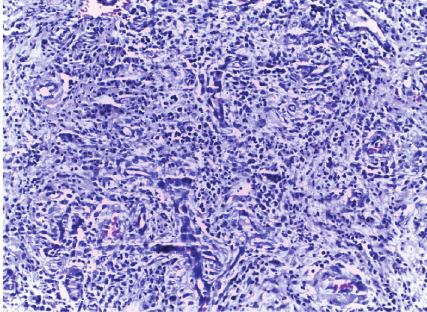
Figure 1: Tuberculous abscess in lower outer quadrant of right breast with erythema and peau d’orange.